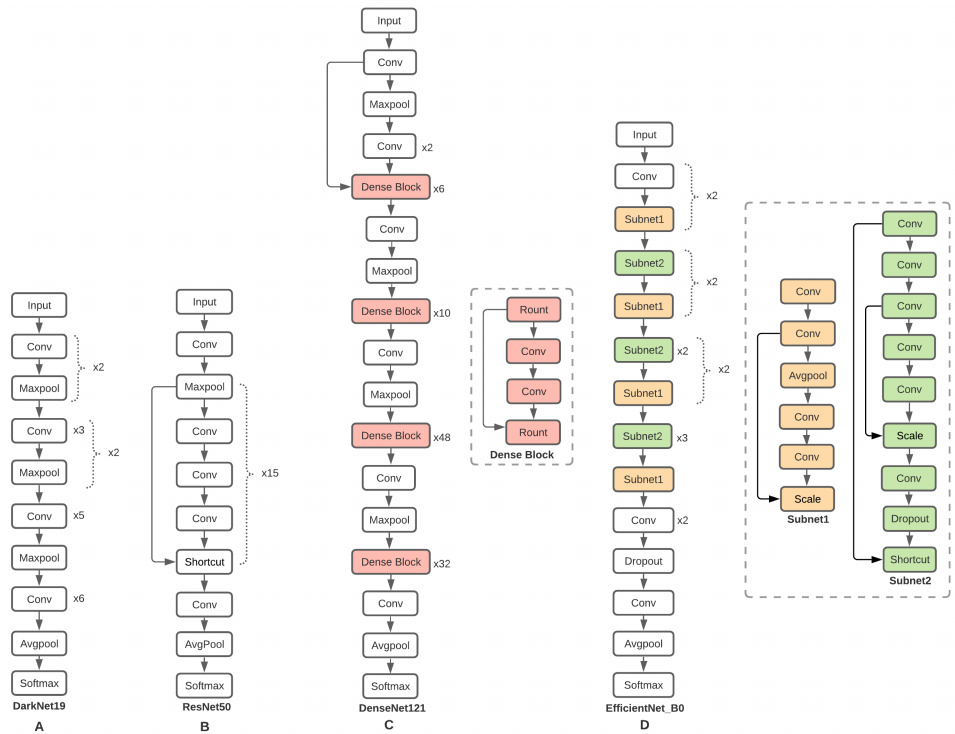
Figure 2. CNN networks used in this study. DarkNet-19 ( A ), ResNet-50 ( B ), DenseNet-121 ( C ), and EfficientNet-B0 ( D